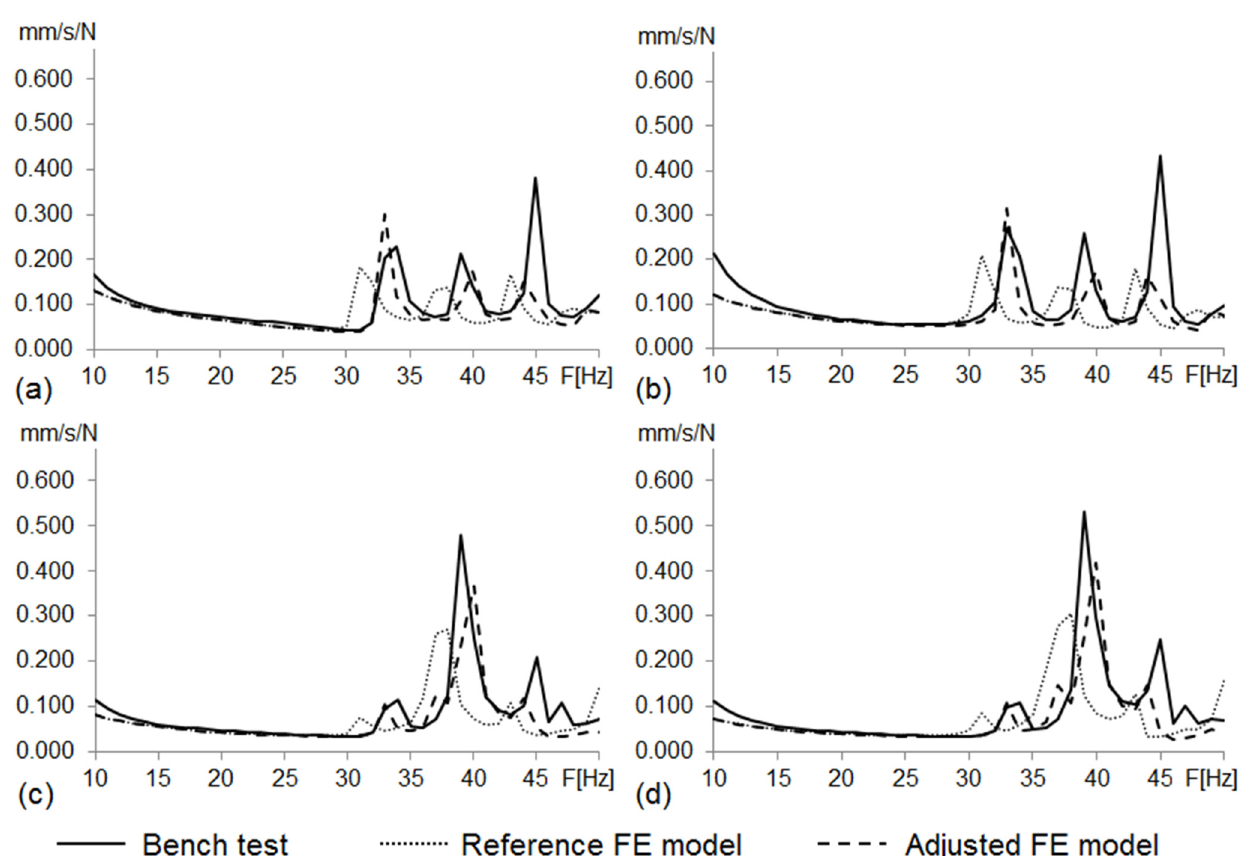
Figure 11. RMS curves from body structure bench test, reference and adjusted FE model FRFs (driver seat attachment vibration responses to unitary excitation). ( a ) Load at front left shock tower; ( b ) at front right shock tower; ( c ) at rear left shock tower; ( d ) at rear right shock tower.